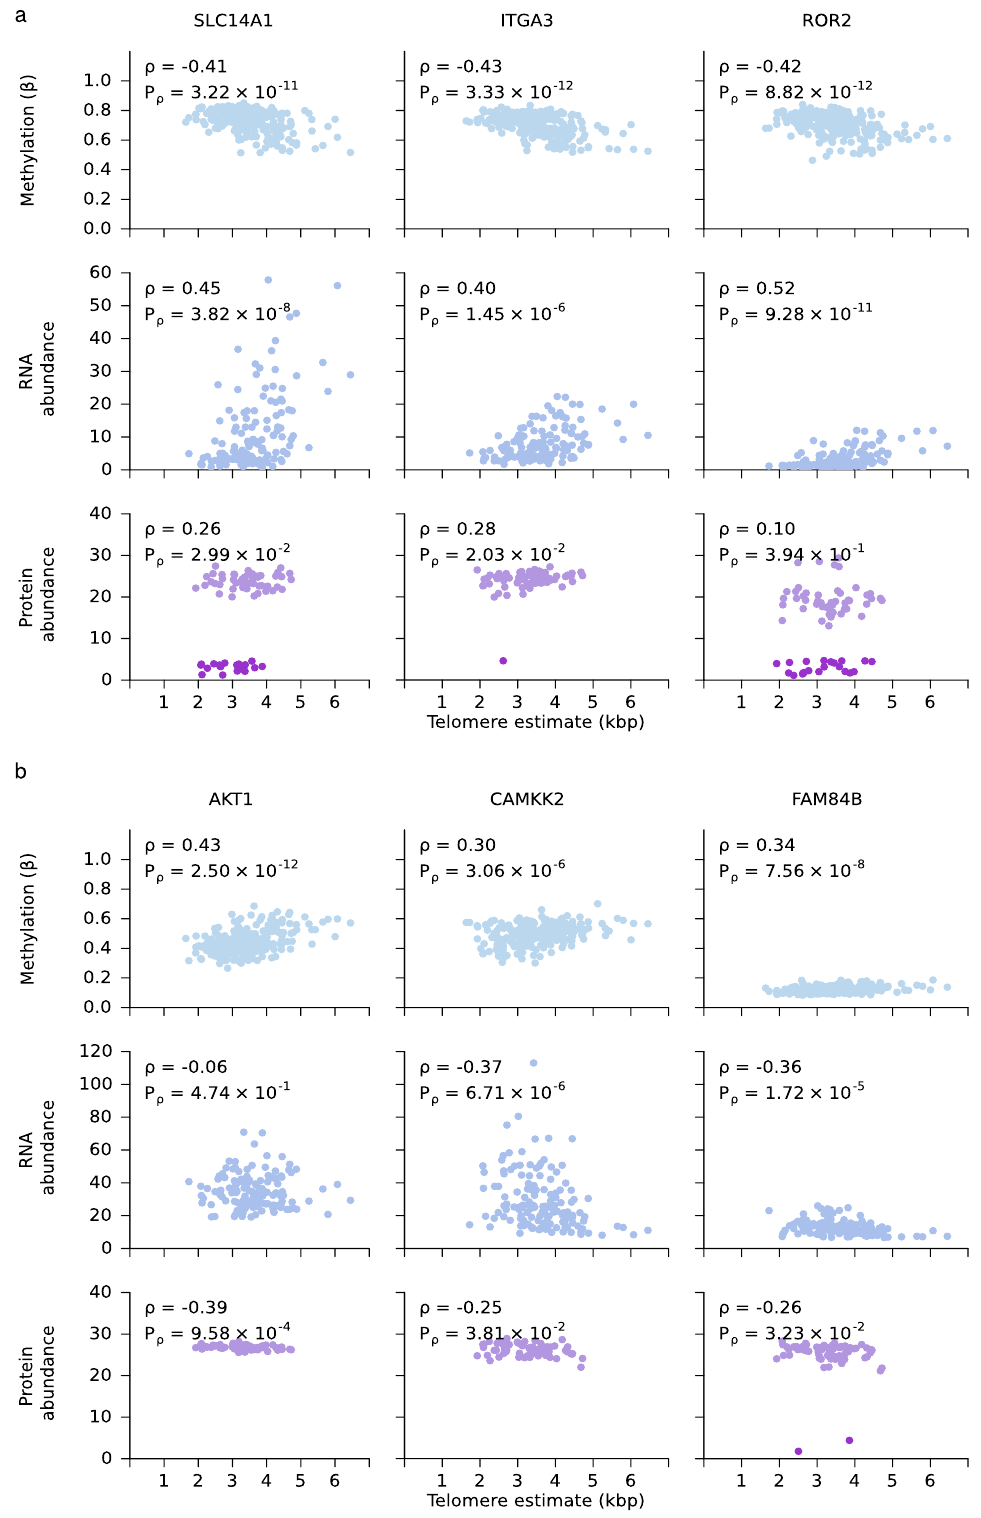
Fig. 4 Association of methylation, RNA abundance, protein abundance and TL. a Positive correlation of methylation and tumour telomere length (TL), but negative correlation of RNA and protein abundance. b Negative correlation of methylation and tumour TL, but positive correlation of RNA and protein abundance. Darker purple dots represent undetected, imputed protein abundance measures. Spearman ’ s ρ and P -values are displayed, two-sided.